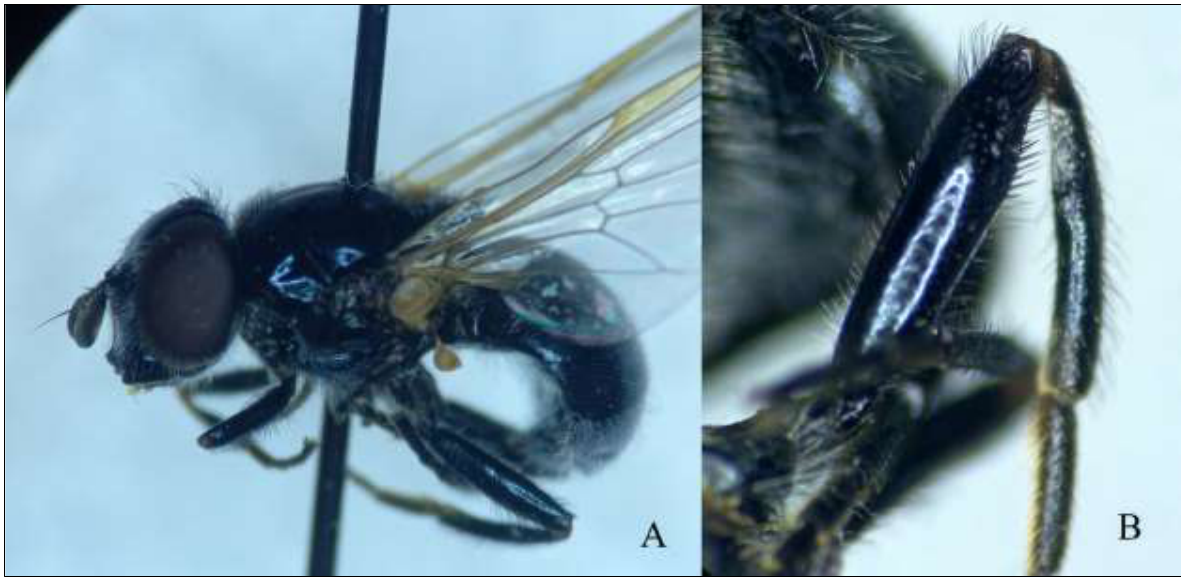
Figure 6. Psilota atra (Fallén, 1817); A − habitus of female, lateral view; B − hind femur of female. (Photo: M. Vujić,